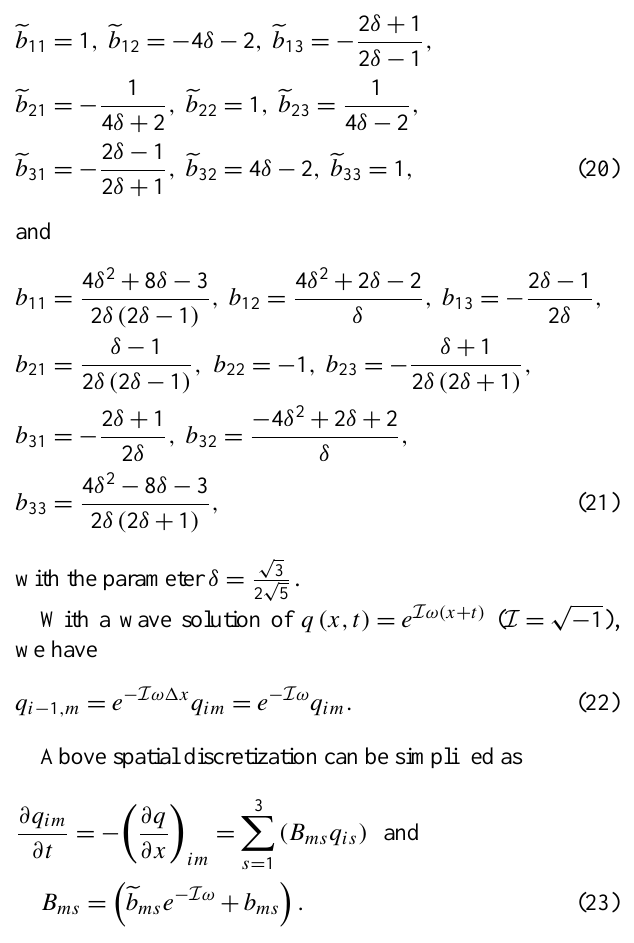
Fig. 3. Numerical properties of several schemes were ana- tra and Fig. 2 for numerical dispassion and dispersion rela- tions. We conduct a comparison between DG3 (three-point discontinuous Galerkin scheme; Huynh, 2007), MCV5 (fifth- order multi-moment constrained finite volume scheme; Ii and Xiao, 2009) and the proposed scheme since these three schemes have the fifth-order accuracy and can be derived by FR framework using different constraint conditions for spa- tial reconstruction of flux functions. As detailed in Huynh (2007), the DG3 scheme uses the Radau polynomial as the correction functions to derive the flux reconstruction which assure the continuity of the numerical fluxes computed from Riemann solvers at the cell boundaries. The MCV5 scheme using multi-moments proposed in Xiao et al. (2013).